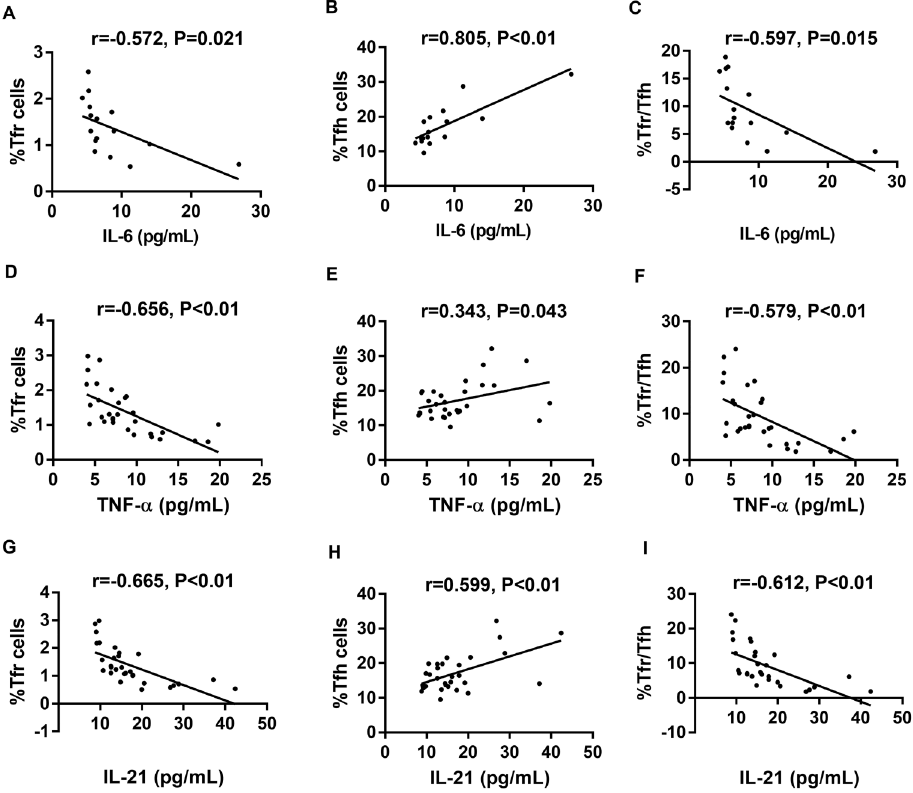
Figure 5. Correlation analysis between Tfr and Tfh cells rates and Tfr/Tfh with the level of cytokines in dilated cardiomyopathy (DCM) patients. Tfr cell rate was negatively correlated with interleukin (IL)-6 ( A , n=16), tumor necrosis factor (TNF)- a ( D , n=30), and IL-21 ( G , n=30). Tfh cell rate was positively correlated with IL-6 ( B , n=16), TNF- a ( E , n=30), and IL-21 ( H , n=30). Meanwhile, Tfr/Tfh was negatively correlated with IL-6 ( C , n=16), TNF- a ( F , n=30), and IL-21 ( I ,